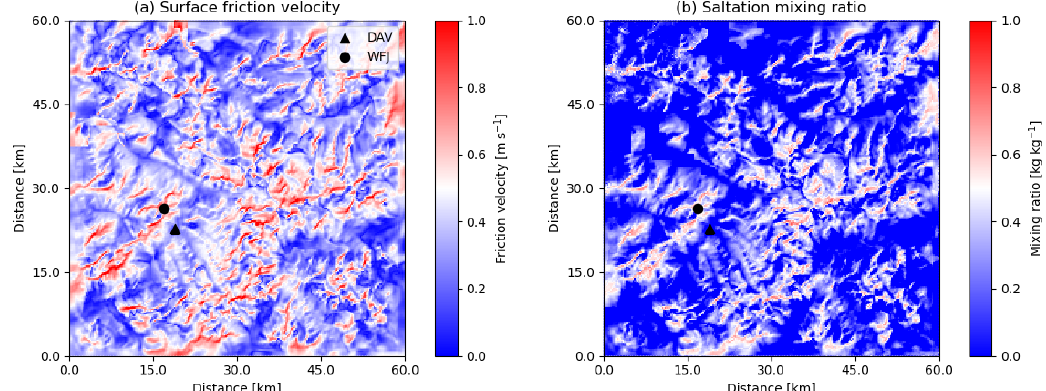
Figure 16. Modelling of snow transport. (a) Surface friction velocity that triggers saltation. (b) Mixing ratio of blowing snow in the saltation layer. Stations DAV and WFJ are marked by a black triangle and circle, respectively. Results shown are at 00:00UTC on 12 March 2019.